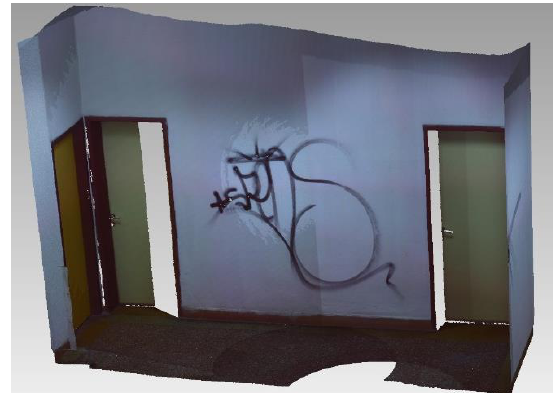
Figure 6 3D model of the wall section captured by Faro Focus